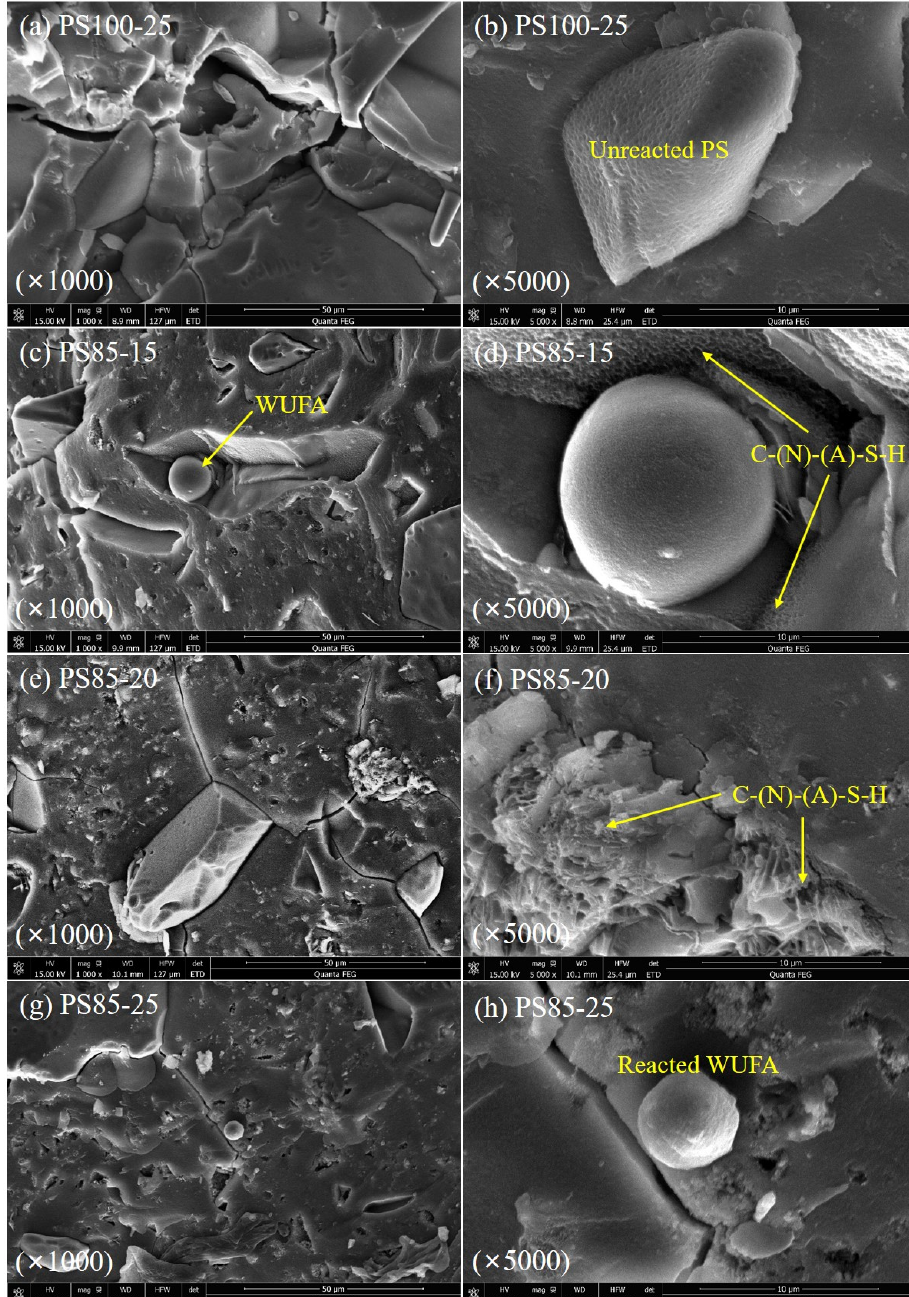
Figure 12. SEM images of PS ( a , b ) and WUFA-PS ( c – h )-based geopolymers at 28 days.